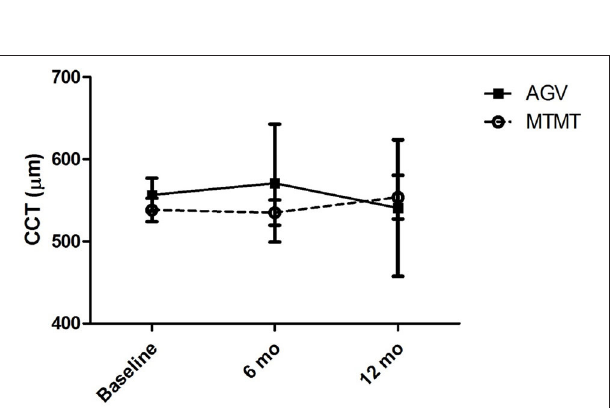
FIGURE 3 | Changes in corneal endothelial cell measurements after anti-glaucoma treatment. (A) Changes in the endothelial cell density (ECD). No significant difference was found between the two groups. There was a significant ECD reduction in the AGV group between baseline and 6 months. There were significant ECD reductions in the AGV group between baseline and 6 and 12 months after the treatment (* p = 0.015, # p = 0.008, ## p = 0.008; Wilcoxon signed-rank test for intra-group analysis). (B) Changes in hexagonality. No significant difference was found between the two groups. There was a significant hexagonality reduction in the AGV group between baseline and 12 months after the treatment in the AGV group (** p = 0.018; Wilcoxon signed-rank test). (C) Changes in coefficient of variation. No significant difference was found between the two groups, and between before and after the treatment in each group.